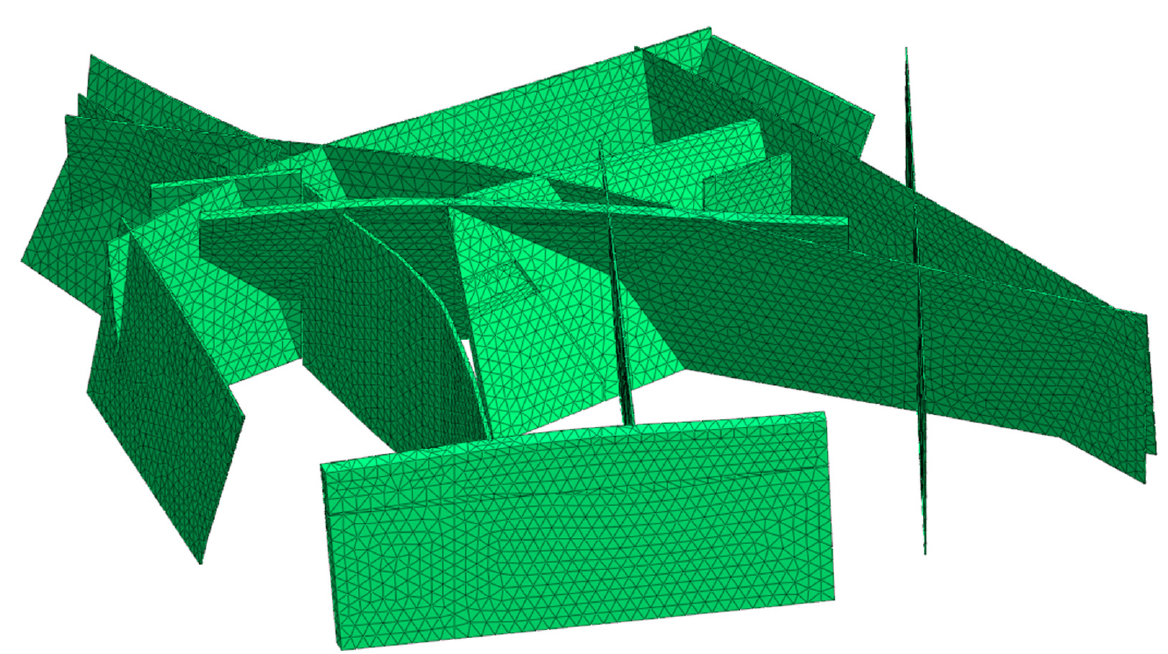
Figure 2. Hydrogeological model of the reservoir area.